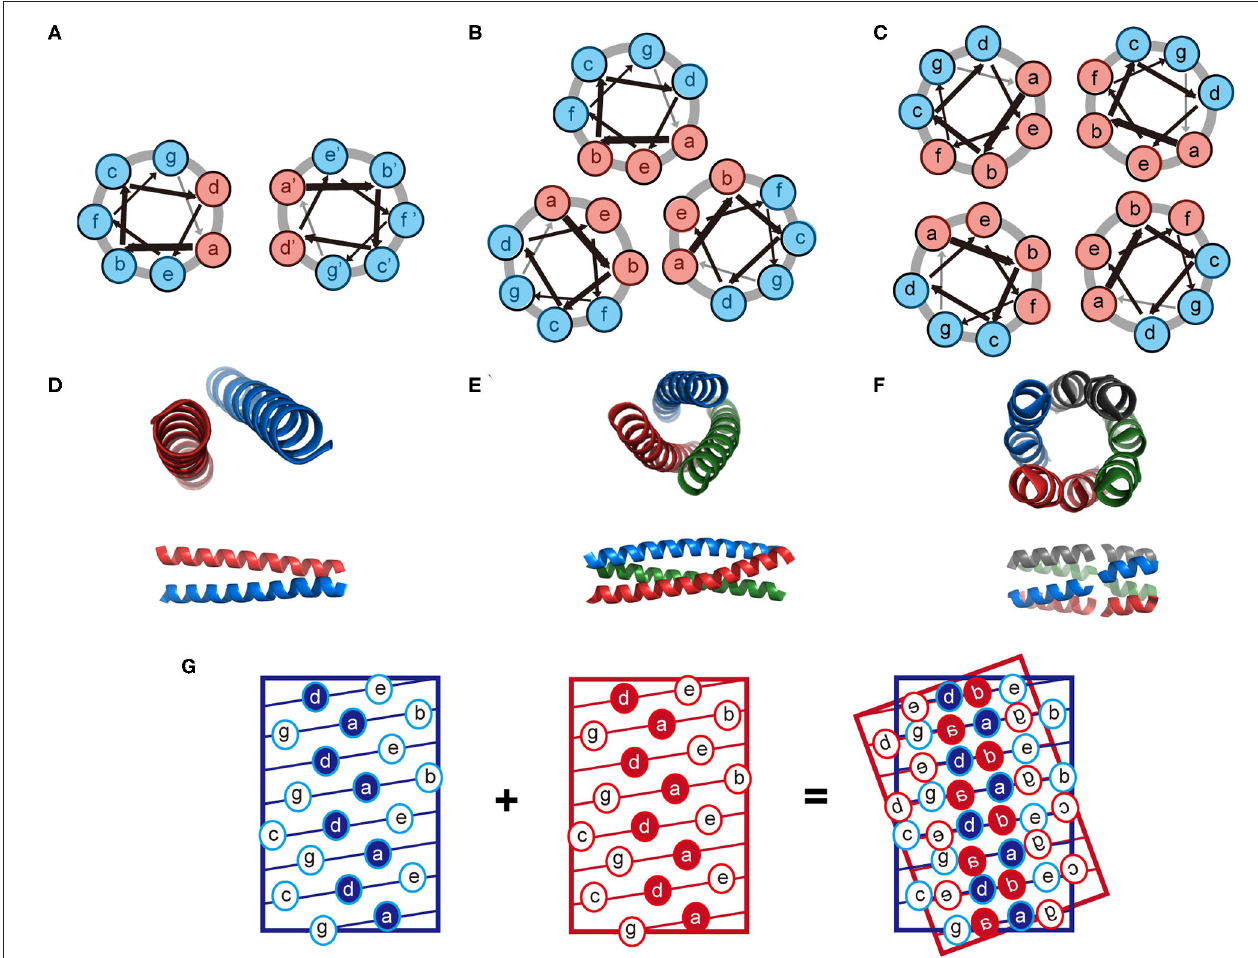
FIGURE 2 | Schematic illustration of the coiled-coil structure. (A–C) Helix-wheel diagrams of the coiled-coil dimer (A) , trimer (B) , and tetramer (C) . Light red is referred to a non-polar residue and light blue is referred to a polar residue. Arrows with different thickness present the rotating manner of residues along the helix. ( D–F ) Coiled-coil dimer ( D , PDB ID 4DZM), trimer ( E , PDB ID 1OX3), and tetramer ( F , PDB ID 2AG3) viewed from along the helix axes (top) and perpendicular to the helix axes (bottom). (G) A knobs-into-holes packing regime in a coiled-coil